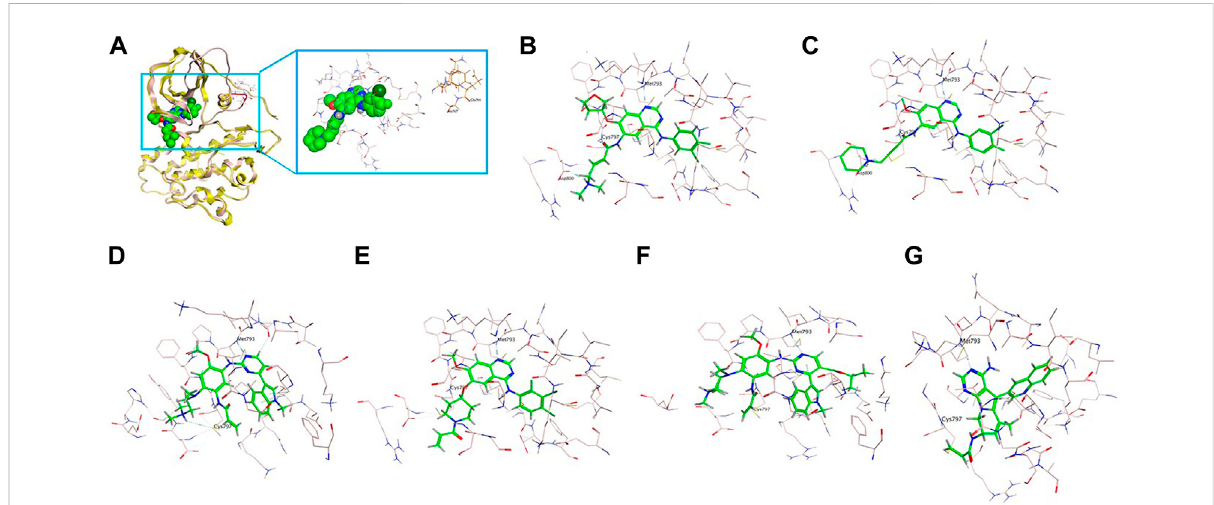
FIGURE 2 3D-based structure of A763_Y764insFQEA variant (A) with the binding pocket (marked in pink) of a certain inhibitor (marked in green) and the inserted amino acids FQEA (marked in brown). Binding modes of diverse EGFR TKIs including afatinib (B) , dacomitinib (C) , osimertinib (D) , poziotinib (E) , mobocertinib (F) , and CLN-081 (G) for the A763_Y764insFQEA variant.